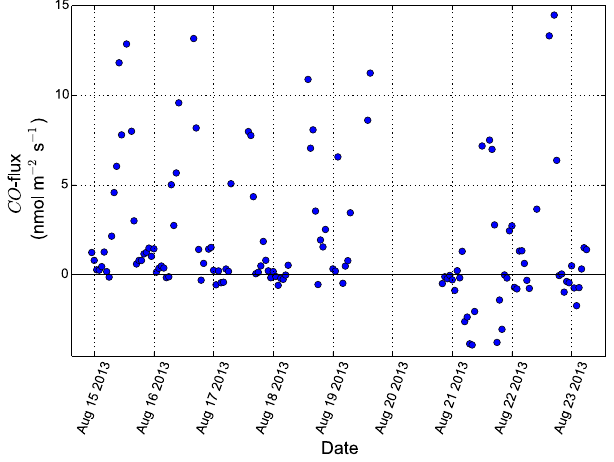
Figure 1. Flux Gradient CO measurements over 8days in August. A large rain event took place on 20